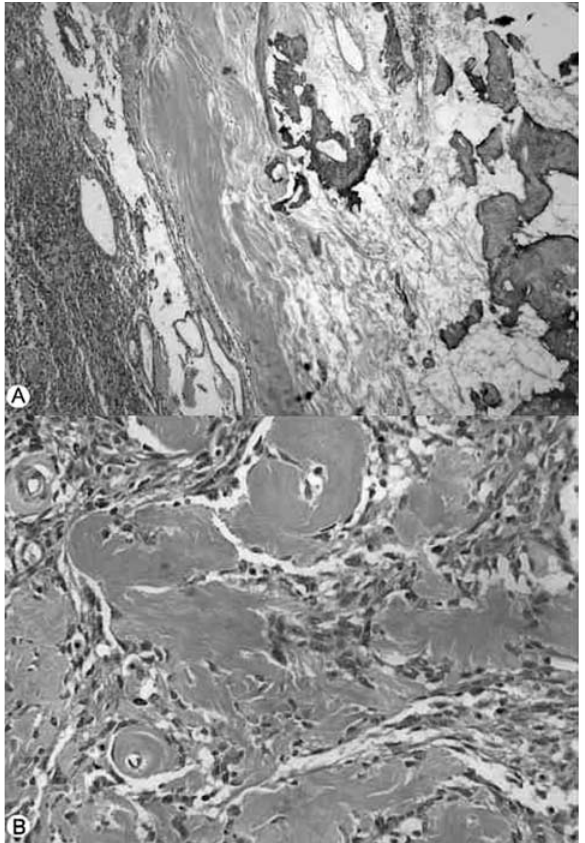
Figure 3 – Microscopy appearance. (A) Classic zonation phenomenon described in myositis ossificans was easily observed with orderly progression of osteoid formation to mature bone from the center to tumor periphery (hematoxylin & eosin, 200x magnifica- tion); (B) Hypercellular population of immature stromal cells lacking cytologic